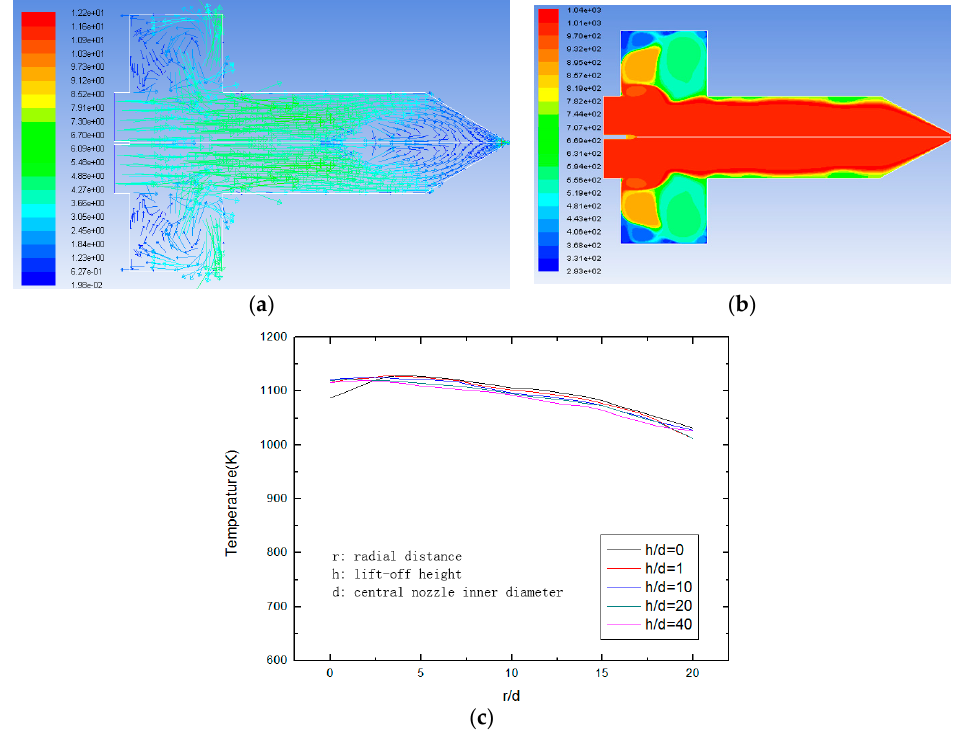
Figure 5. Velocity and temperature distributions from simulation. ( a ) Velocity field; ( b ) temperature field; ( c ) temperature distribution.